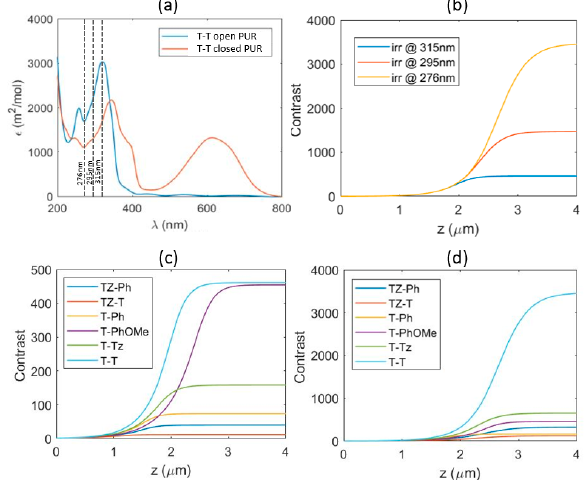
Figure 5. ( a ) Molar extinction coefficients for the open- and closed-ring forms of T-T -based PU. The dashed lines indicate the illumination wavelength considered, including the best (276 nm) and the worst (315 nm) conversion conditions. ( b ) Simulated contrast vs. the thickness of a polyurethane film for T-T -based PU. Simulated contrast vs. the thickness of the different photochromic polyurethanes ( c ), considering the wavelength of irradiation at the UV peaks of the open-ring form and ( d ) considering the best irradiation wavelength.